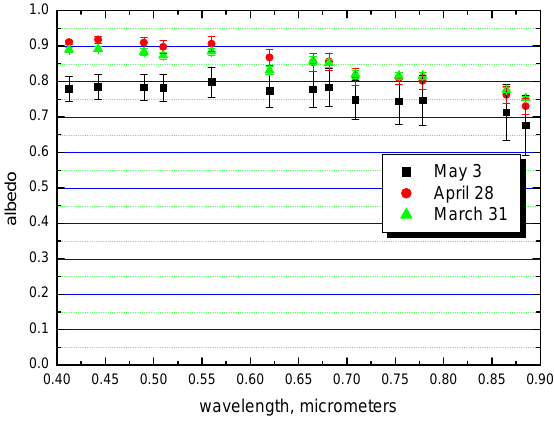
Fig. 9. The albedo retrieved from MERIS observations for several days in 2006 (average for all orbits). As it should be, albedo decreases with the wavelength and it is smaller for days with higher temperature. The results for the point with the coordinates (24.6 ◦ E, 79.8 ◦ N) are given (glacier Austfonna, island Nordaustlandet on